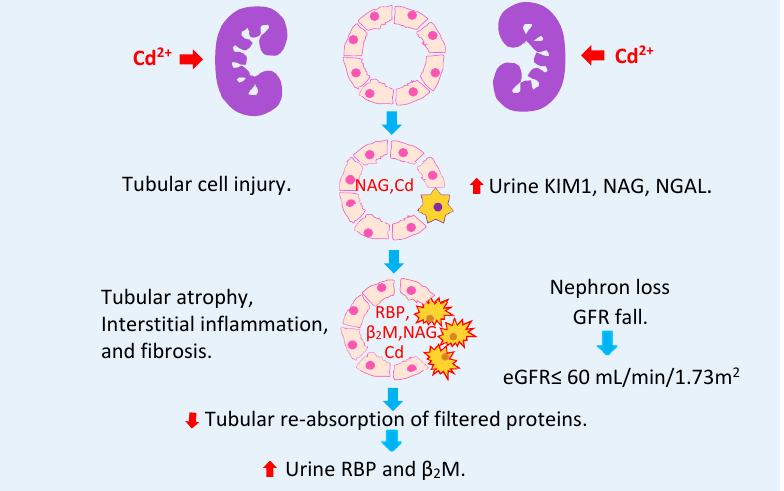
Figure 2. Sequential outcomes of tubular cell toxic injury of cadmium accumulation in kidneys. Cd inflicts tubular cell injury at low intracellular concentrations, and the toxicity intensifies as Cd concentration rises [65]. Tubular injury disables glomerular filtration, leading to nephron atrophy, glomerulosclerosis, and interstitial inflammation and fibrosis. A reduction in tubular reabsorption of filtered proteins, RBP and β 2MG follows tubular atrophy and nephron loss. Abbreviation: KIM1, kid- ney injury molecule 1; NAG, N-acetyl- β -D-glucosaminidase, NGAL, neutrophil gelatinase associated lipocalin; RBP, retinal binding protein; β 2 M, β 2